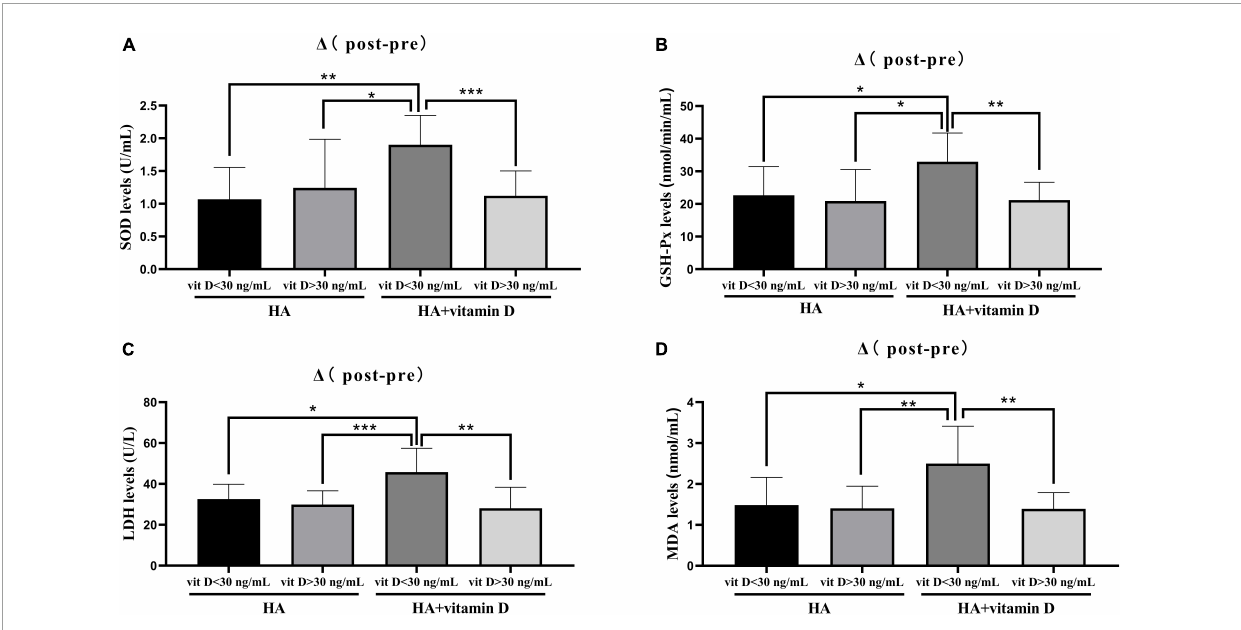
FIGURE1 Changes of OS levels in groups with different vitamin D levels. (A) Change in SOD level after 5 weeks of treatment; (B) Change in GSH-Px level after 5 weeks of treatment; (C) Change in LDH level after 3 months of treatment; (D) Change in MDA level after 3 months of treatment. * p < 0.05, ** p < 0.01, *** p < 0.001.